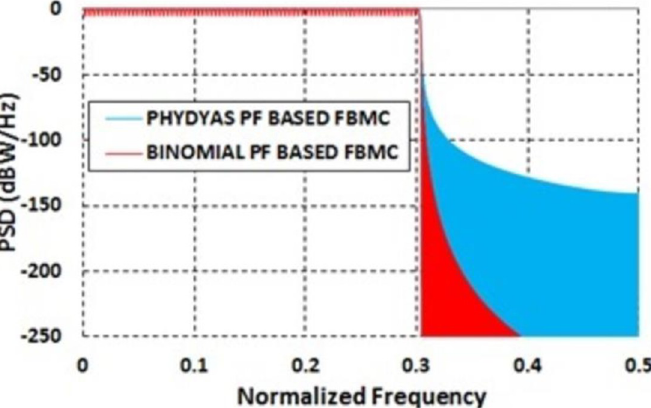
Fig 6. Power spectral densities of PHYDYAS based FBMC and Binomial filter based FBMC.